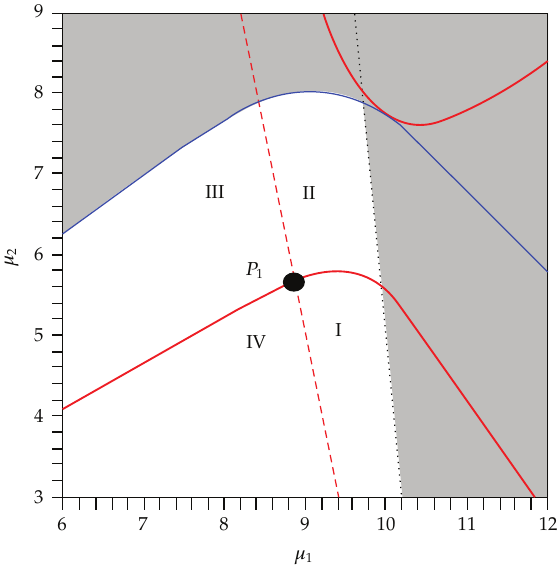
Figure 4: The enlargement of a region near the point P 1 in Figure 3. The red heavy solid line and the red break line partition o ff the blank region to four subregions, labeled as I, II, III and IV, respectively.